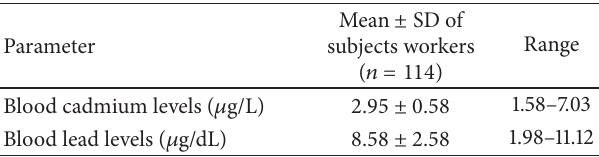
Table 4: Comparison of blood cadmium levels and blood lead levels in subject